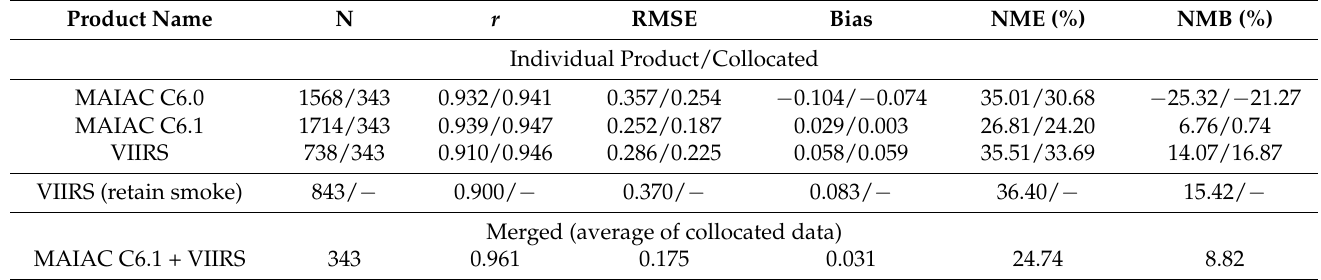
Table 2. Statistical measures of satellite AOD (550 nm) compared with the AERONET data for the 41 sites in western U.S. shown in Figure 1. Results are listed for the validation of each product (MODIS MAIAC C6.0, C6.1, and NOAA-20 VIIRS) individually, for collocated data when the three datasets have valid retrievals simultaneously, and merged data. The metrics shown here include the total number of points (N), Pearson correlation coefficient ( r ), mean bias (MB), root-mean-square error (RMSE), normalized mean bias (NMB) and normalized mean error